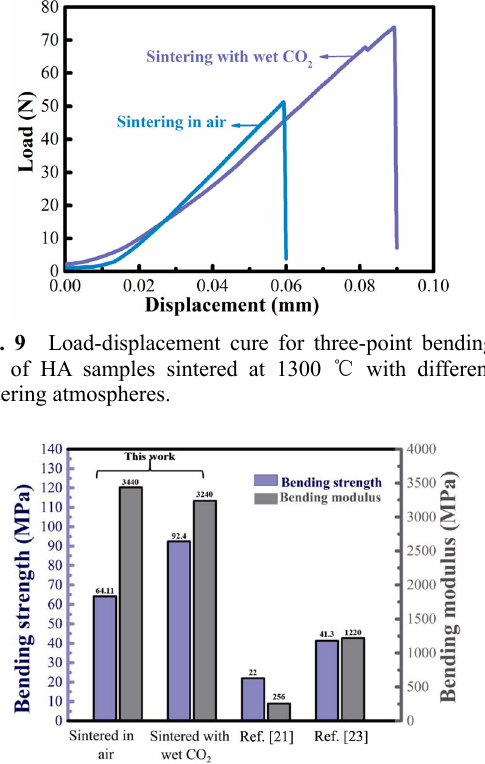
Fig. 10 Comparison of the mechanical properties